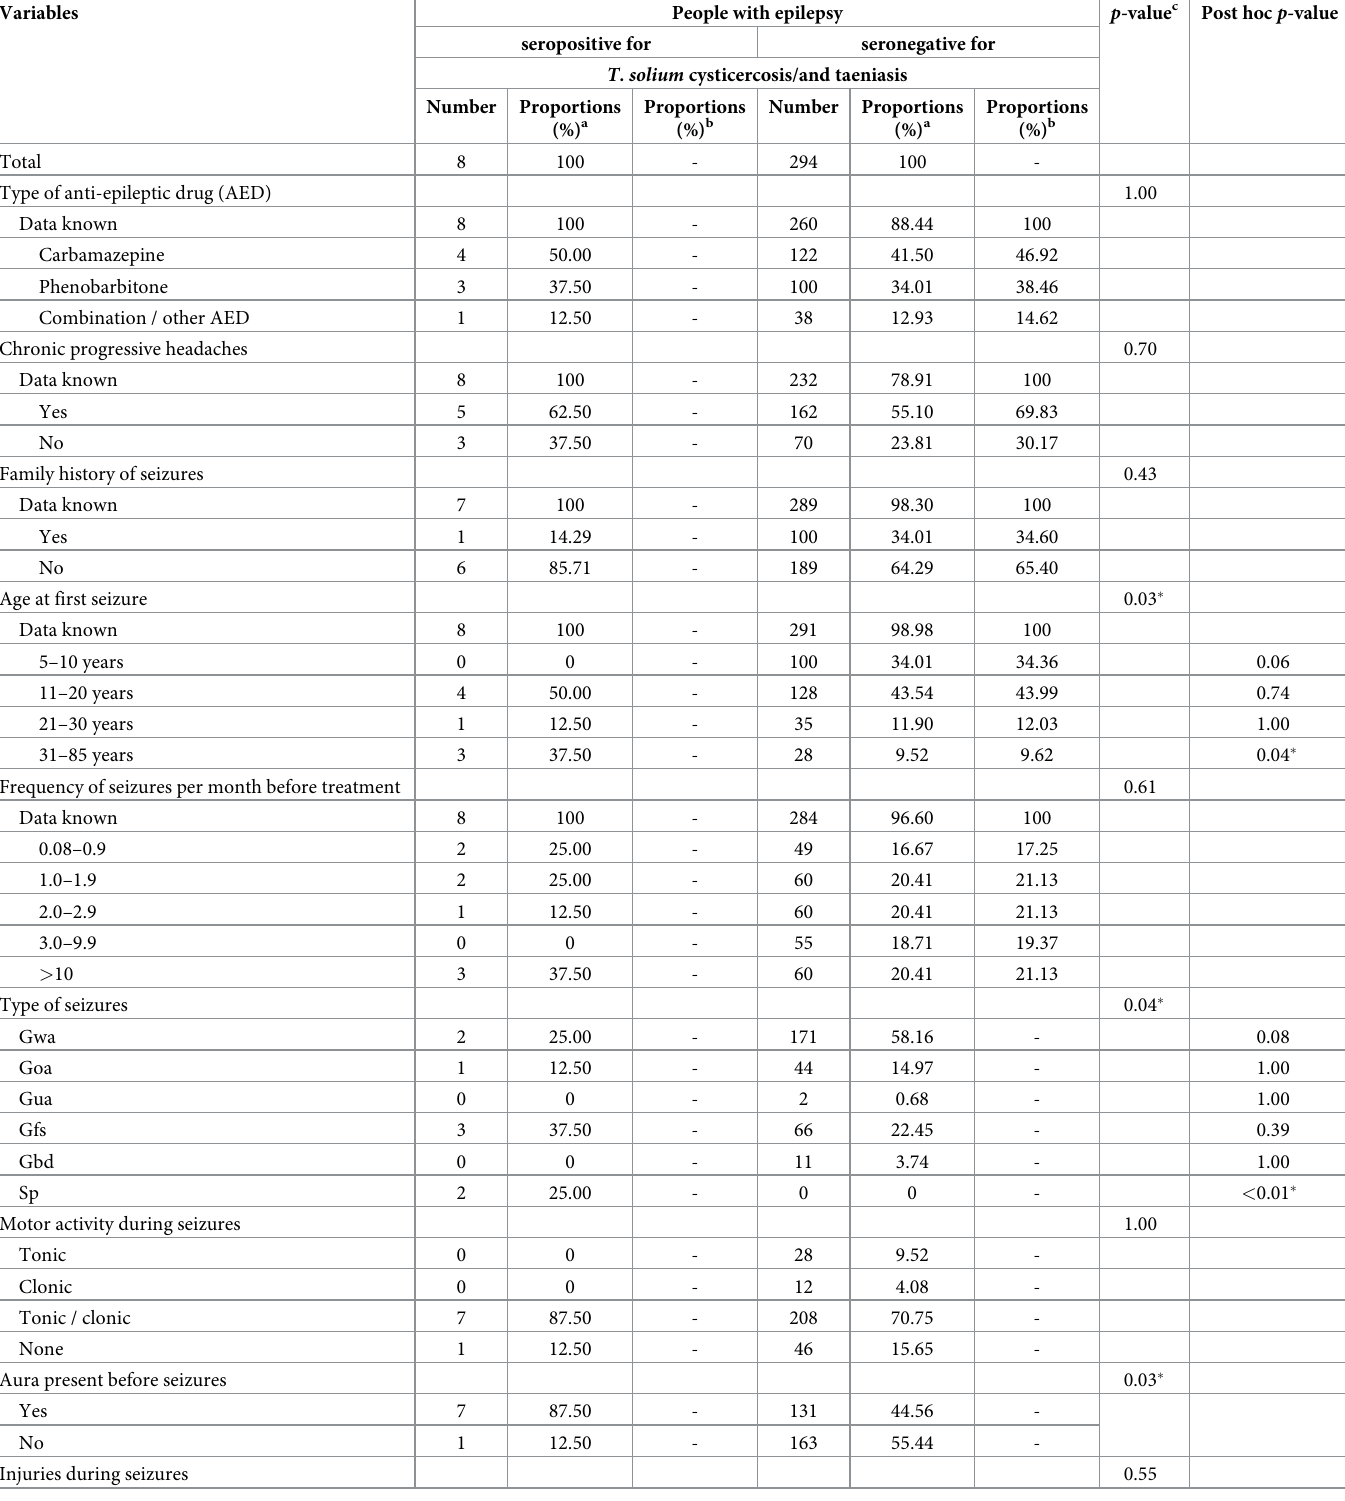
Table 2. Neurological and psychiatric characteristics of people with epilepsy seropositive and seronegative for T . solium cysticercosis and taeniasis.